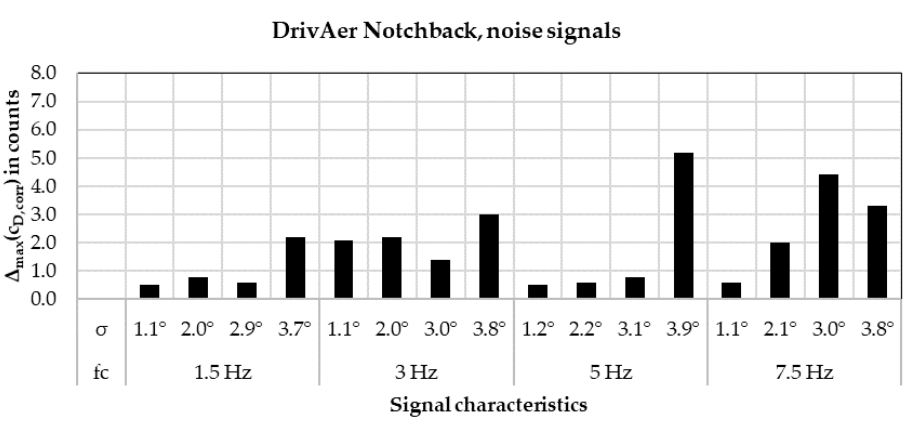
Figure 10. Maximum delta between the three corrected c D values for the DrivAer notchback, measured with noise signals.